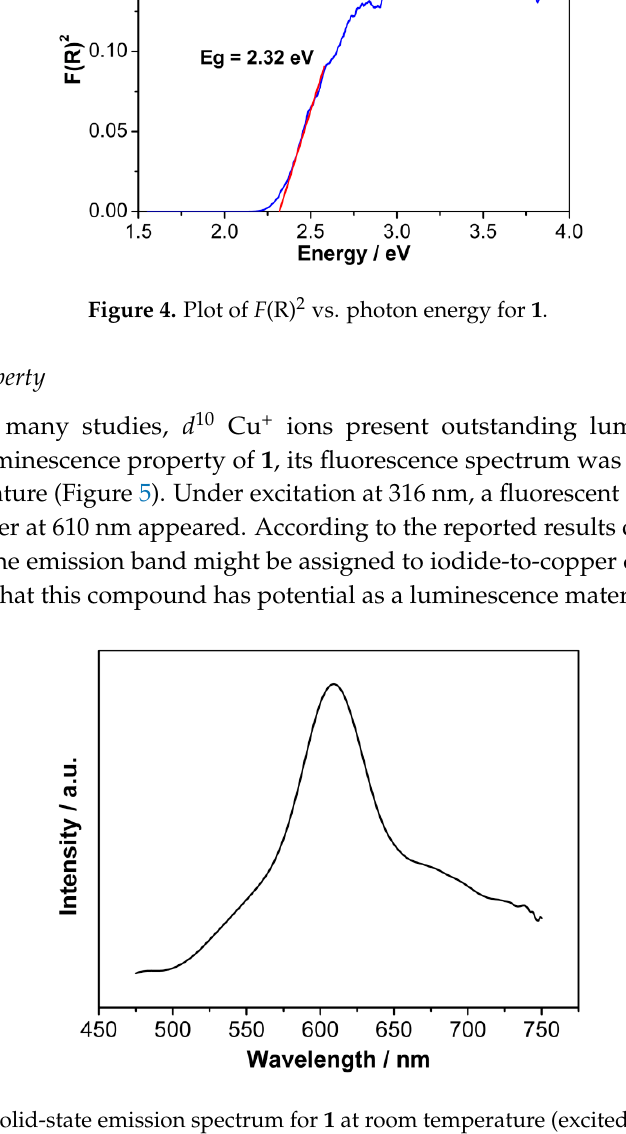
Figure S1: Experimental and simulated powder X-ray diffraction patterns of 1 , Figure S2: TGA curve of 1